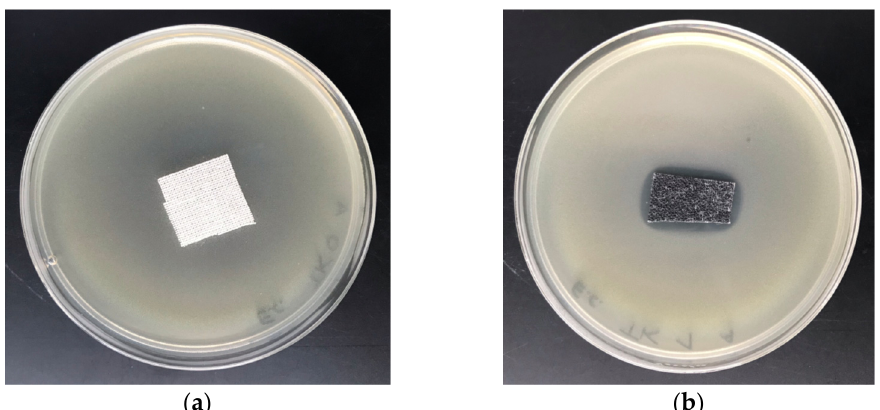
Figure 5. Tests of antimicrobial activity of COT–Zn (0) composites against E. coli. Inhibition zones of bacterial growth in Petri dishes: ( a ) COT; ( b ) COT–Zn-10 (1 s/2 s).